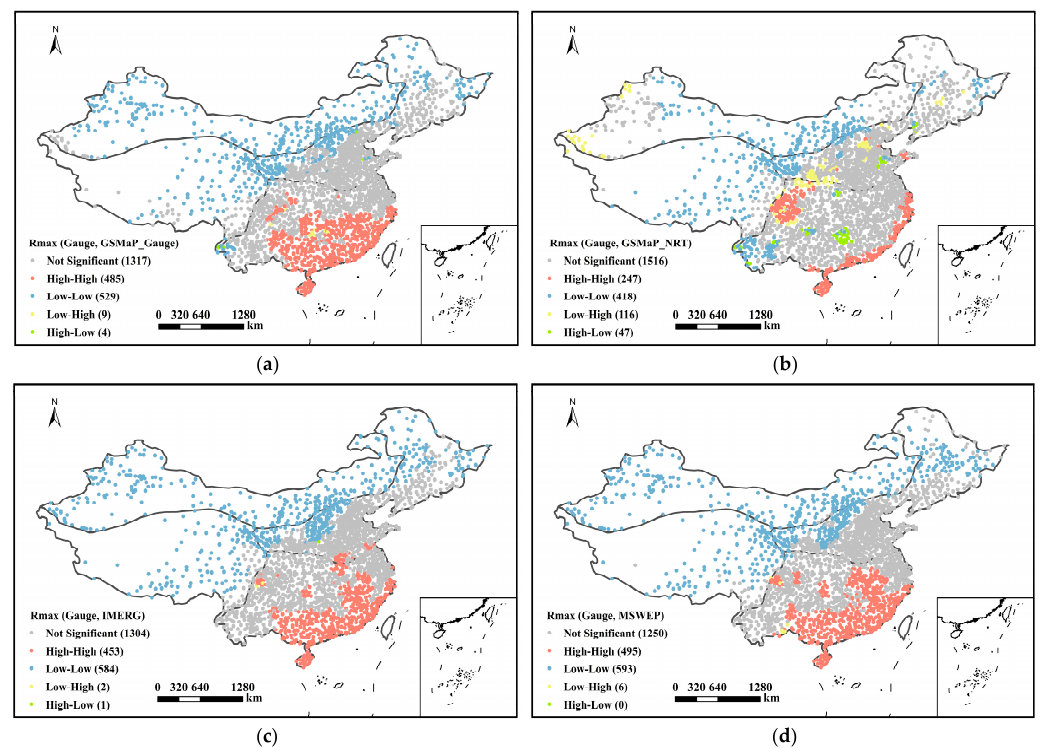
Figure 12. The LISA cluster maps of R95 between the gauge observations and the four SPPs and the number in the bracket represent the corresponding number of gauges: ( a ) GSMaP_Gauge, ( b ) GSMaP_NRT, ( c ) IMERG, and ( d ) MSWEP.